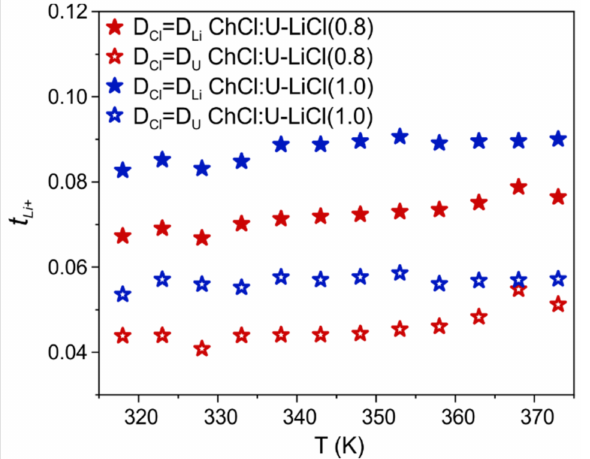
Figure 3. Apparent transference number for lithium ions in the two Li-doped systems (0.8 mol/kg = red, and 1.0 mol/kg = blue), assuming the self-diffusion coefficient of chloride equal to lithium (filled symbols) or urea (empty symbols), as a function of